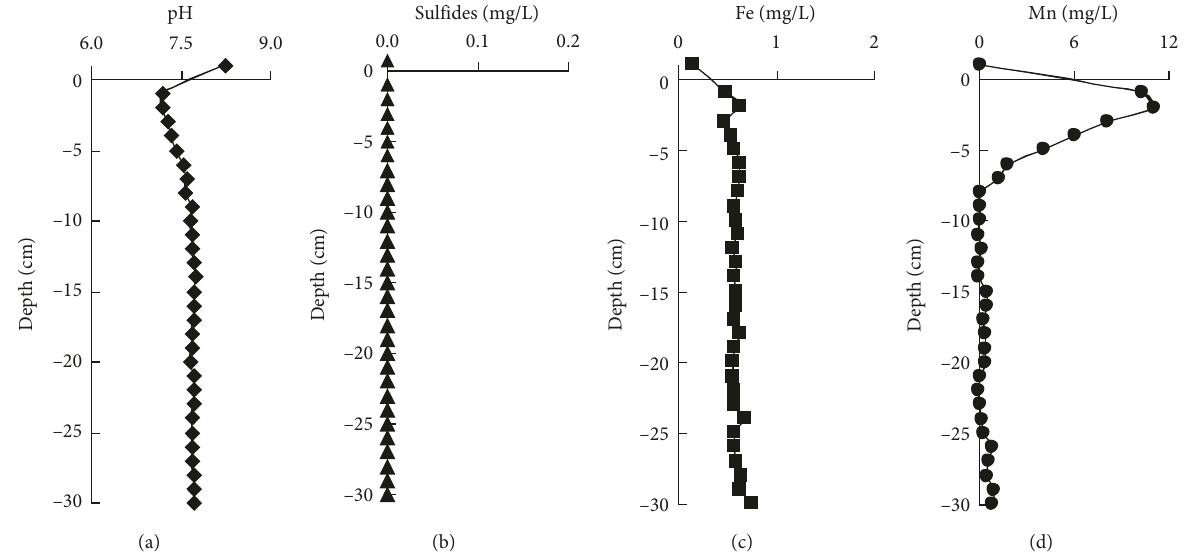
Figure 5: Profiles of pH (a), sulfides (b), dissolved Fe (c), and Mn (d) in porewaters.